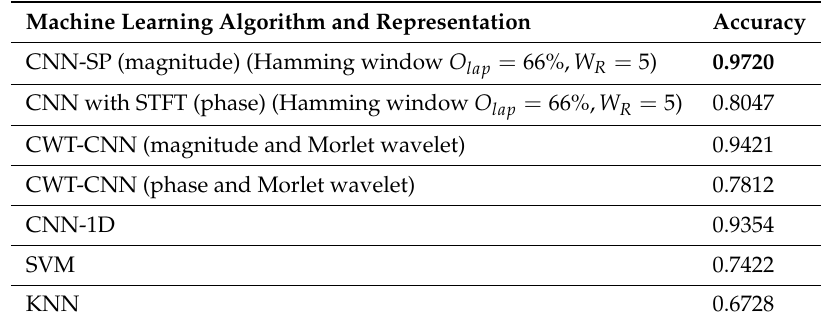
Figure 15. Comparison of the accuracy among the spectrogram CNN approach (CNN-SP) proposed in this paper (for different window sizes), the CNN directly applied to the time domain representation (CNN-1D), and the shallow machine learning techniques (SVM, KNN) applied to the data of the Gyroscope in the Y direction (GyroY). Table 4. Accuracy obtained for the different representations at 50 Hz. Bold represents the highest